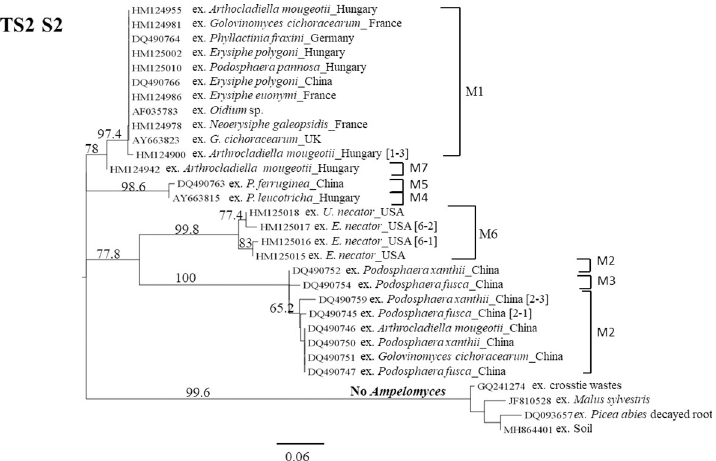
Fig 12. Highly diverse consensus ITS2 S2s from the outgroup taxa. (A) The consensus ITS2 S2 was elaborated without gaps. The GenBank ID numbers of four ITS2 sequences used to predict the ITS2 S2 are indicated. (B) The consensus ITS2 S2 build with gaps. The consensus ITS2 S2s were obtained using the 4SALE v1.7.1 software. The helices are indicated by Roman numerals (I–IV). Nucleotides in yellow indicate the U-U mismatch motifs in helix II. The bar on the upper right side indicates the nucleotide conservation across the four ITS2 sequences used to obtain the consensus structure. Gaps in the structure are indicated in